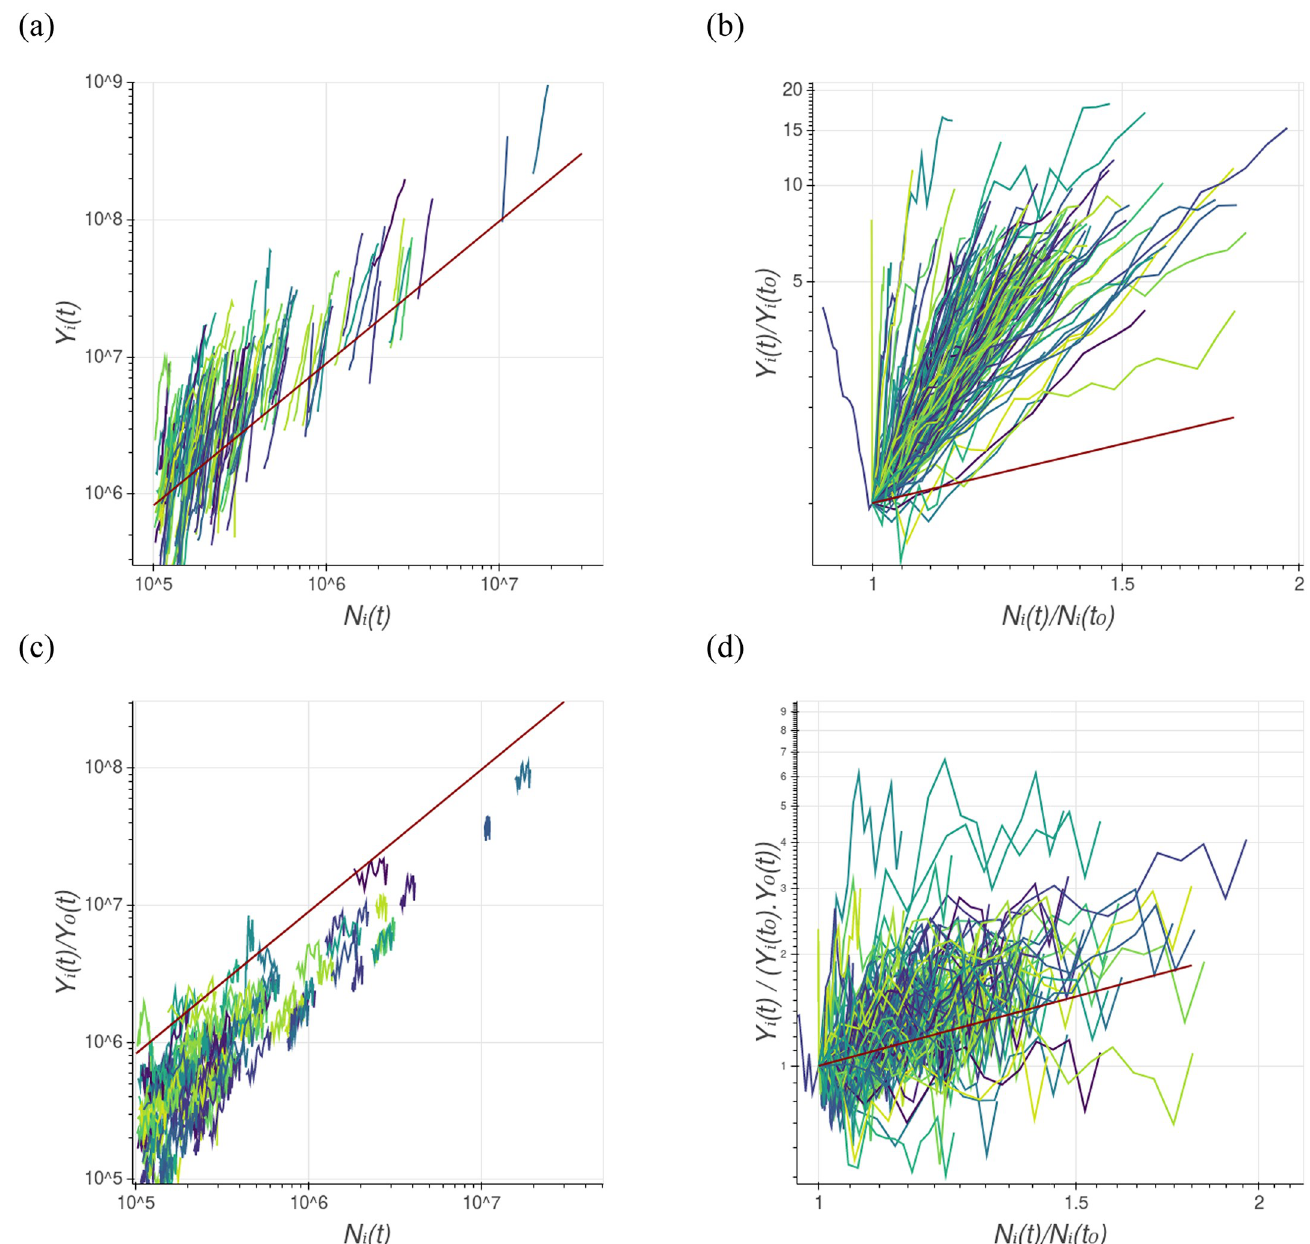
Fig 3. Normalization of longitudinal scaling. Different ways to see the longitudinal dynamics of GDP and population size for all Brazilian cities. Each trajectory represents the time evolution of one single urban area, from the year 1998 to 2014. a) log-log plot of the time evolution of the raw data of GDP as a function of population size. The dark red straight line is the power-law equation, with the average transversal scaling exponent � b of the longitudinal dynamics, which allows us to compare the slopes of the cities’ trajectory. This graph shows us that cities have different slopes, and they are greater than � b , represented by the dark red line. c) Decomposed longitudinal trajectory, which allows seeing the dynamics without global effects. d) Decomposed T and re-scaled form of the longitudinal dynamics, which shows that the individual slopes are compatible with the transversal scaling exponent, represented by the dark red line. The distribution of the individual slopes (for raw and decomposed data) can be seen in Fig 4.